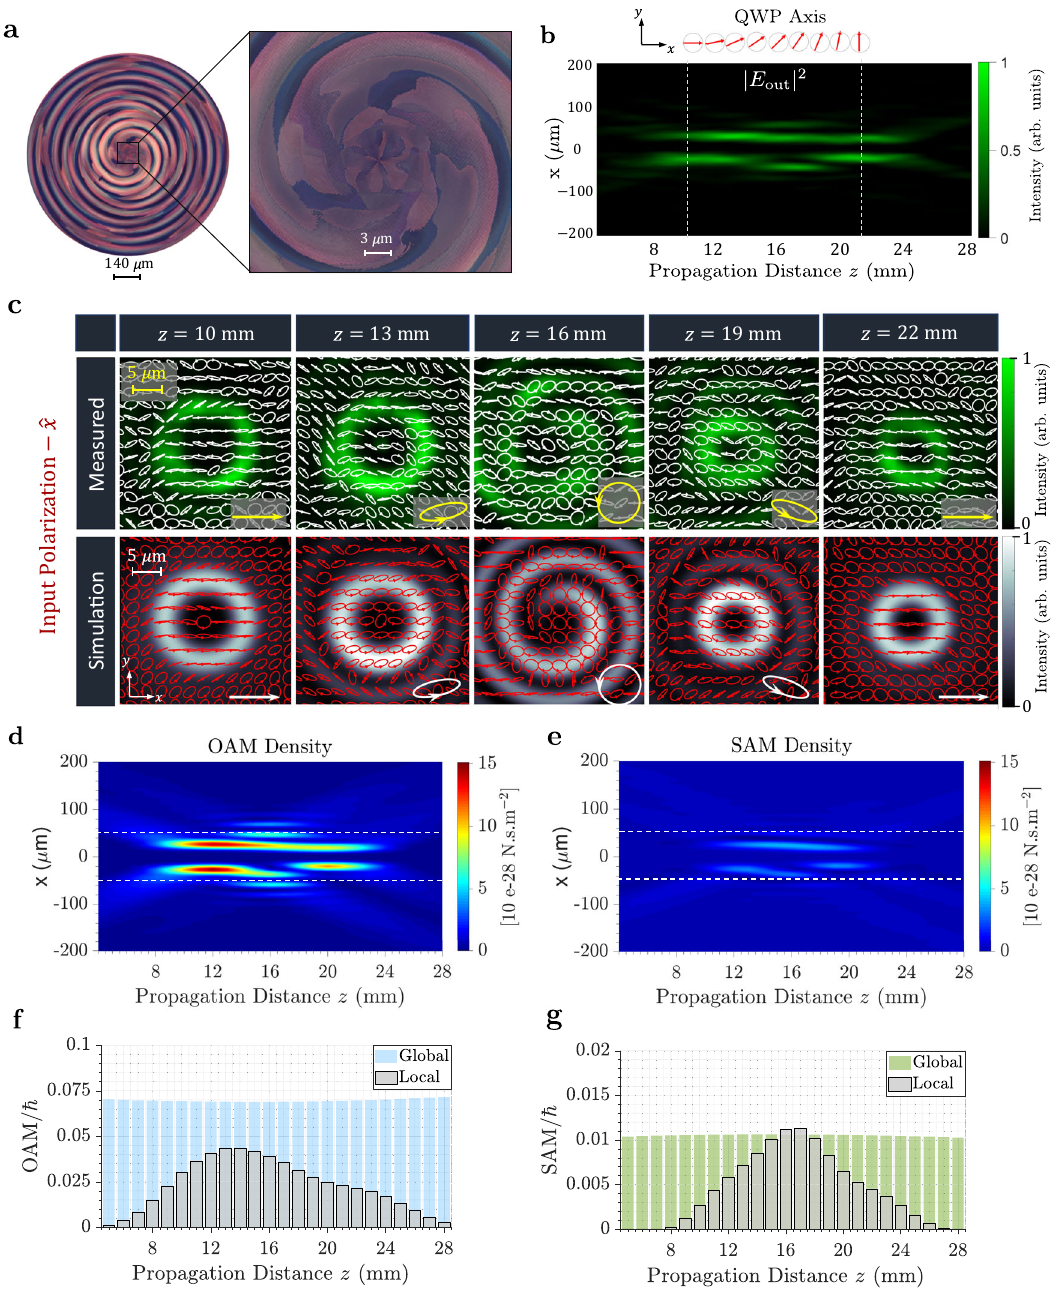
Fig. 4 Versatile TAM plate for independent SAM and OAM control along the direction of propagation. a Optical microscope images of the device. b Measured longitudinal intensity pro fi le at the output in response to incident x -polarization. The polarization response here is chosen to mimic a quarter- waveplate (QWP) with rotating fast axis, as shown by the red arrows. c Measured and simulated transverse intensity pro fi les of the generated vortex, Ψ 3 → 2 , in response to x -polarization, exhibiting a transition in the topological charge from ℓ = 3 to ℓ = 2. The state of polarization, obtained from Stokes polarimetry, is shown across the spatial extent of the beam, exhibiting a variation in the ellipticity at different propagation distances, as expected from a z - dependent quarter-waveplate-like device. d , e Simulated density maps depicting the OAM density ( d ) and SAM density ( e ) along the direction of propagation. f OAM values plotted as a function of propagation distance, obtained by integrating the OAM density in ( d ) at each transverse plane. The integration is performed twice considering two different aperture sizes: 100 μ m (marked by the dashed lines in ( d )) and 500 μ m. We refer to these integrated values as local and global OAM, respectively. g Local and global SAM obtained by integrating the SAM densities in ( e ) using the same limits of integration as ( f ). In both cases, while the OAM/SAM can vary locally their global quantities are always conserved with ℓ = 1 to ℓ = 2 with propagation. The measured longitudinal polarization response that mimics a half-waveplate whose fast intensity pro fi le is depicted in Fig. 5b. The polarization response axis rotates with propagation. Figure 5a shows optical images of mimics a HWP retarder with a fast axis that rotates as denotes by the fabricated sample with a diameter of 924 μ m. The device is the red arrows. When illuminated by x -polarized light such a designed to create a vortex beam which changes its charge from